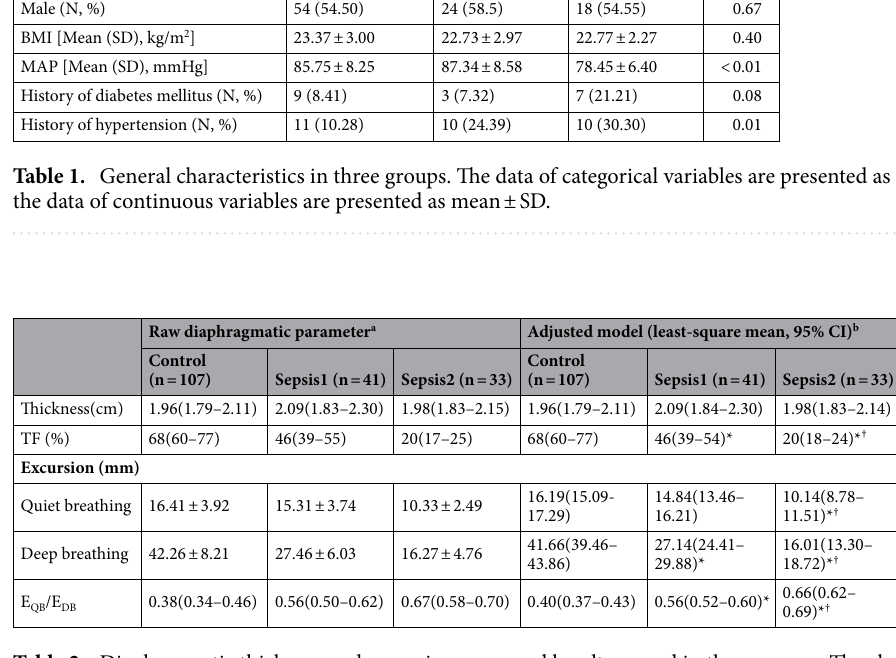
AUDMC in the inspiratory phase. We measured the area under diaphragmatic movement curve (AUDMC) in the inspiratory phase of breathing. Per breathing AUDMC in two septic groups was lower than that in con-